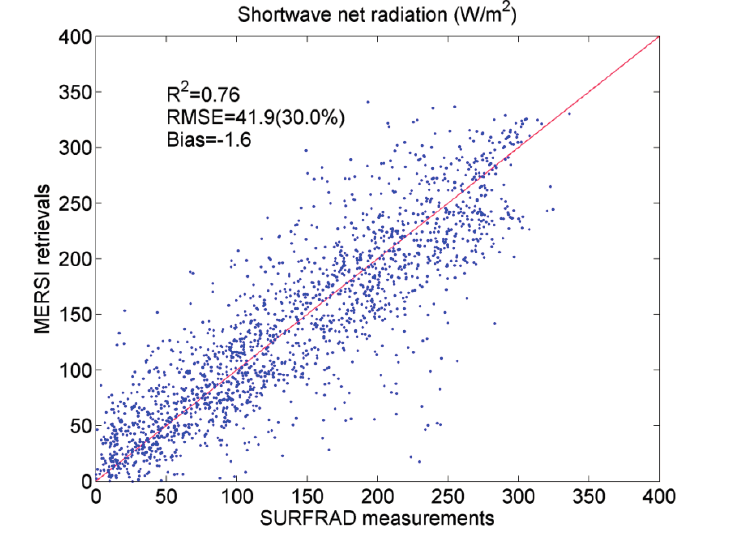
Figure 2. Scatter plot between daily SSNR measured at SURFRAD stations and retrieved from MERSI at the original spatial